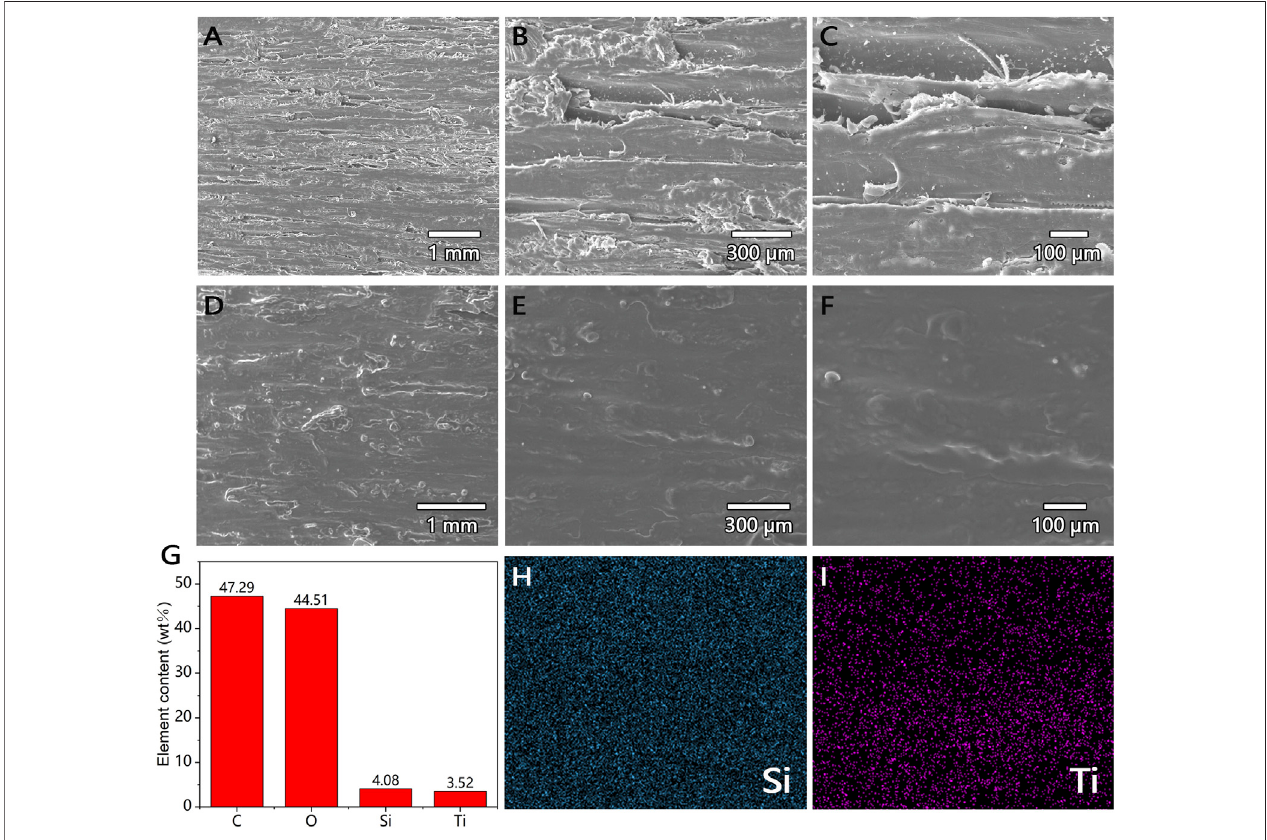
FIGURE 2 | The microscopic appearance of NW and CW. (A – C) SEM images of NW surface. (D – F) SEM image of the CW surface, showing the coating on the surface. (G) Relative element content of CW. (H – I) Energy dispersive X-ray spectroscopic maps shows the element distribution of Si and Ti on the CW surface.